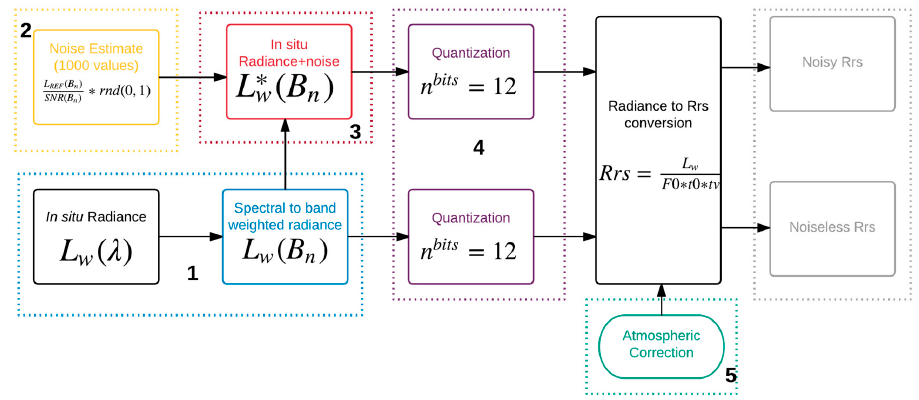
Figure 3. Framework of the proposed simulation for a single spectrum of one orbital sensor.